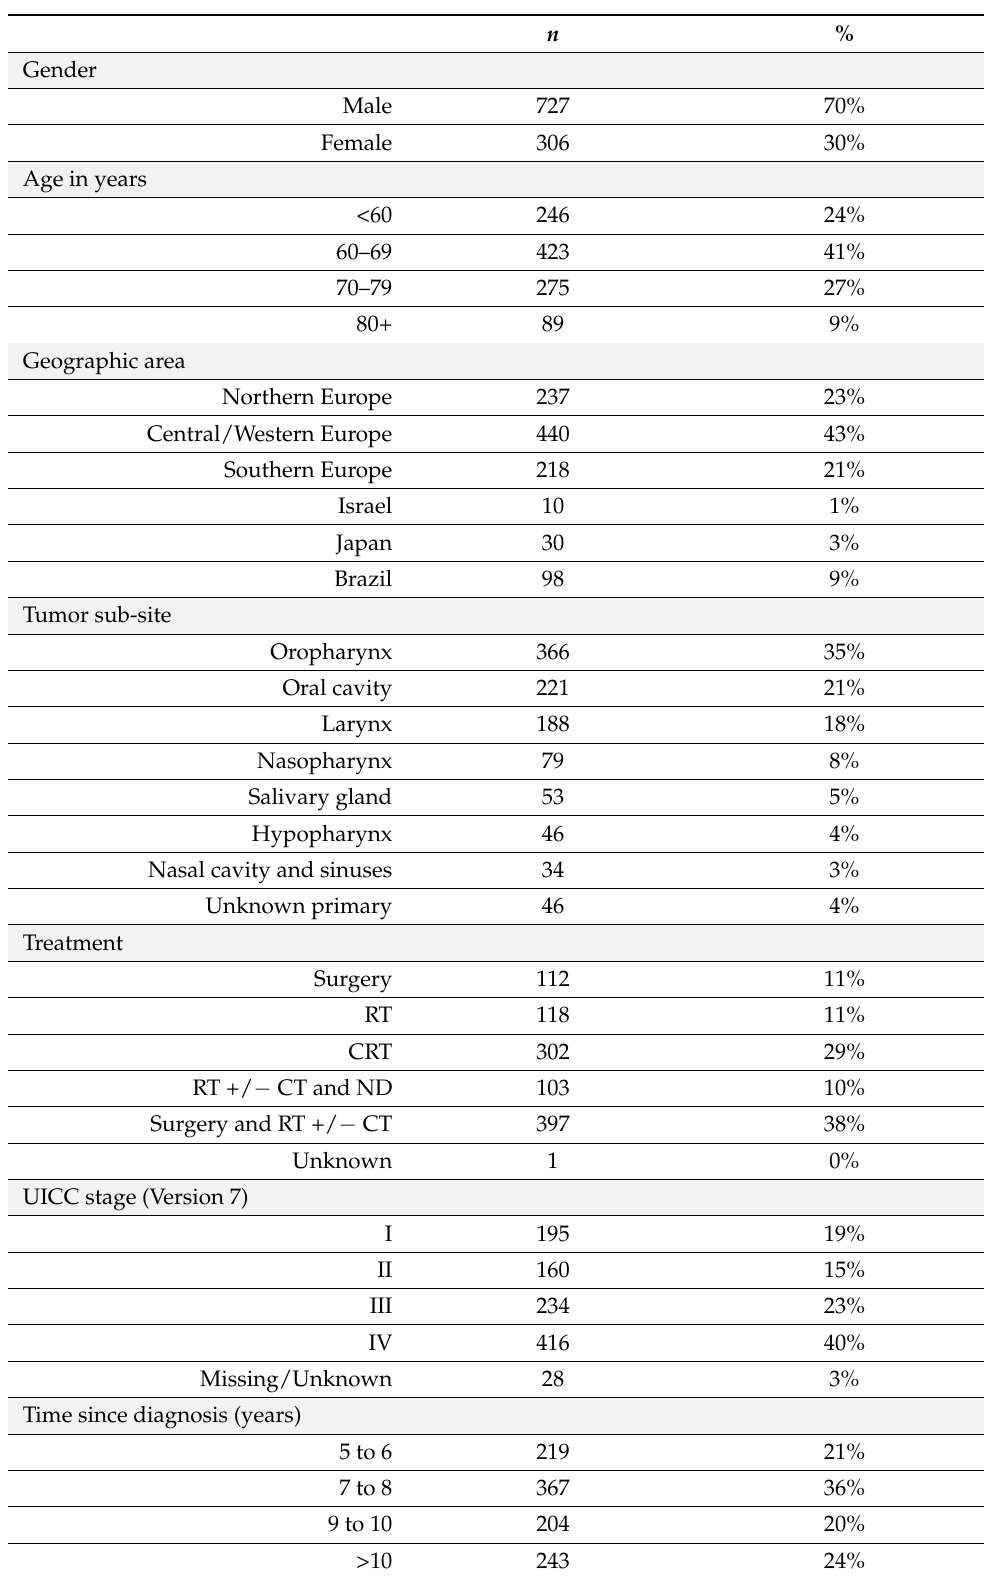
Table 1. Characteristics of the 1033 survivors who gave a response to the long-term effects question.